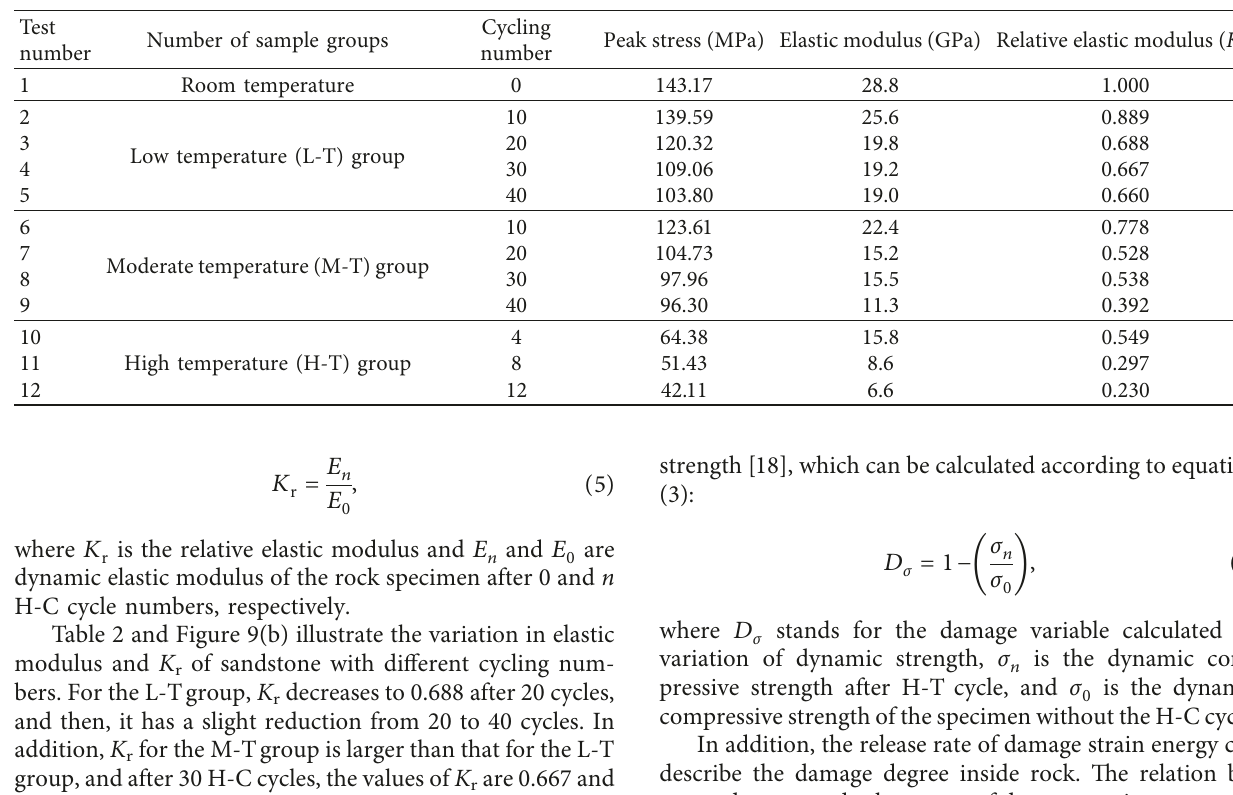
Table 2: Test results on the basic dynamic properties of sandstone after H-C